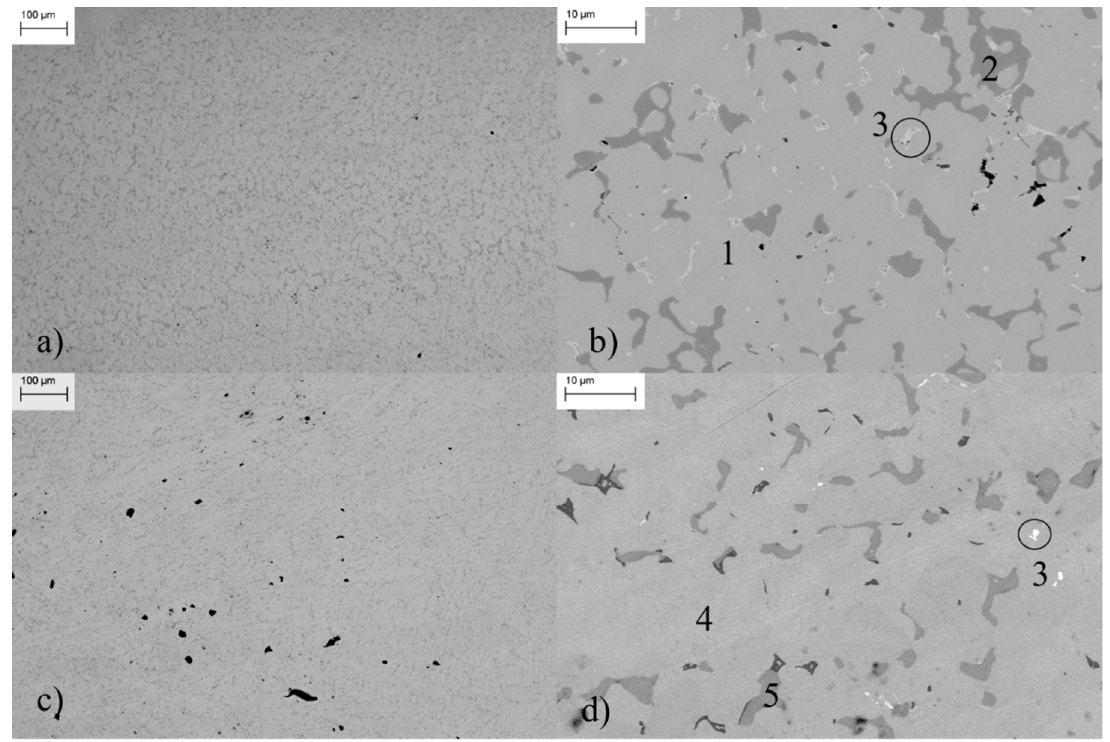
Figure 2. Backscattered electrons SEM images of the Co 2 ZrSn ( a , b ) and Co 2 HfSn ( c , d ) annealed alloys. In accordance with the results of the Rietveld refinement of the XRD patterns (Figure 1 and Table 1), the observed phases are the L2 1 -type Co 2 ZrSn full-Heusler (1), the C15-type Co 2 Zr (2), CoSn (3), the L2 1 -type Co 2 HfSn full-Heusler (4), and the C15-type Co 2 Hf (5).